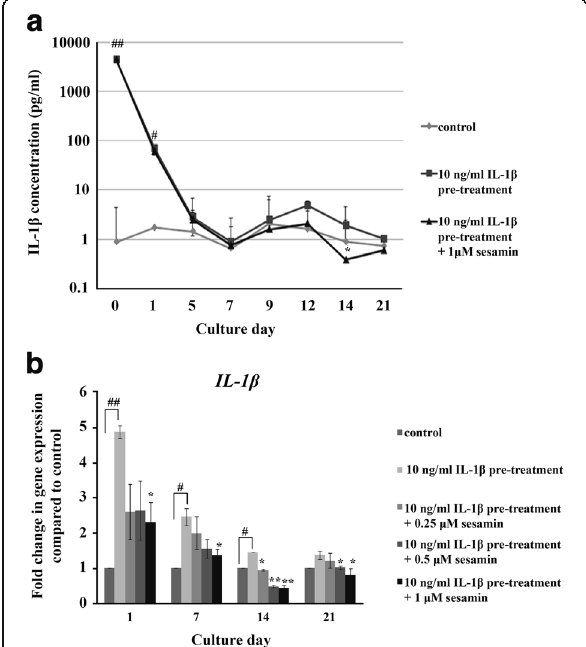
Fig. 2 Effects of IL-1 β and sesamin on the level of IL-1 β in the culture media of 3 day IL-1 β pre-treated HAC pellets ( a ). The effects of sesamin on IL-1 β gene expression in IL-1 β pre-treated HAC pellets ( b ). Data are the mean ± S.D. of three independent cultures. Statistical significance of IL-1 β pre-treatment alone vs untreated (control): # = p < 0.05, ## = p < 0.01 and sesamin treatment vs IL-1 β pre-treatment alone: * = p < 0.05, ** = p <